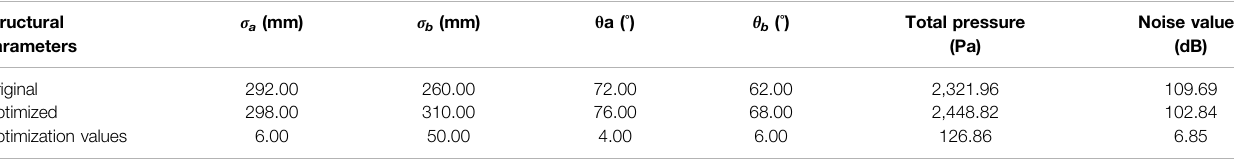
TABLE 3 | Structural parameters corresponding to the optimal solution. Structural